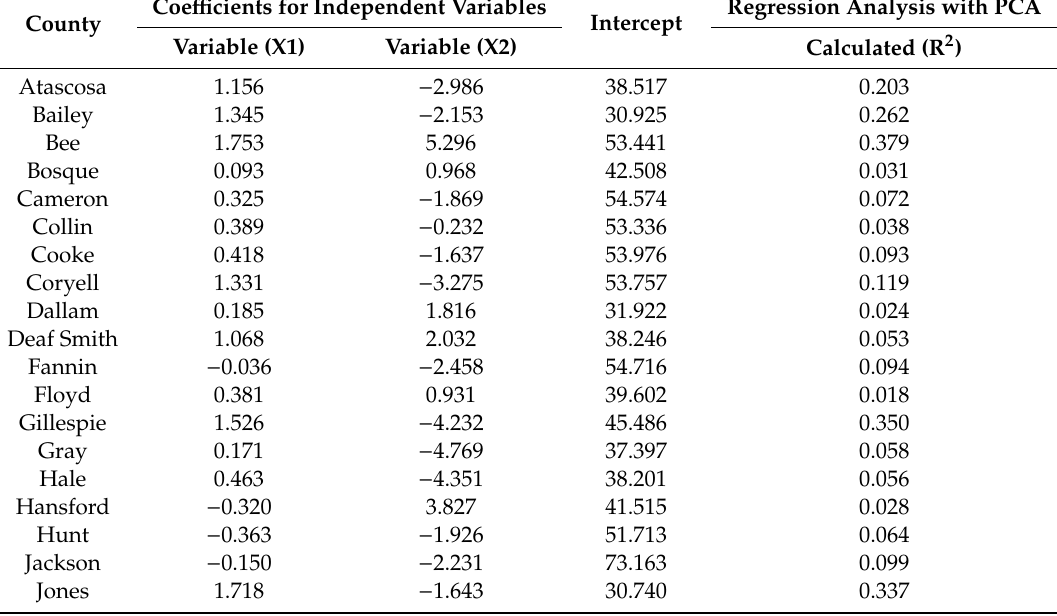
Table 7. Results of multiple linear regression analysis (with PCA for removing the relationship between the two independent variables) using annual growing season precipitation, 4-day maximum precipitation, and crop